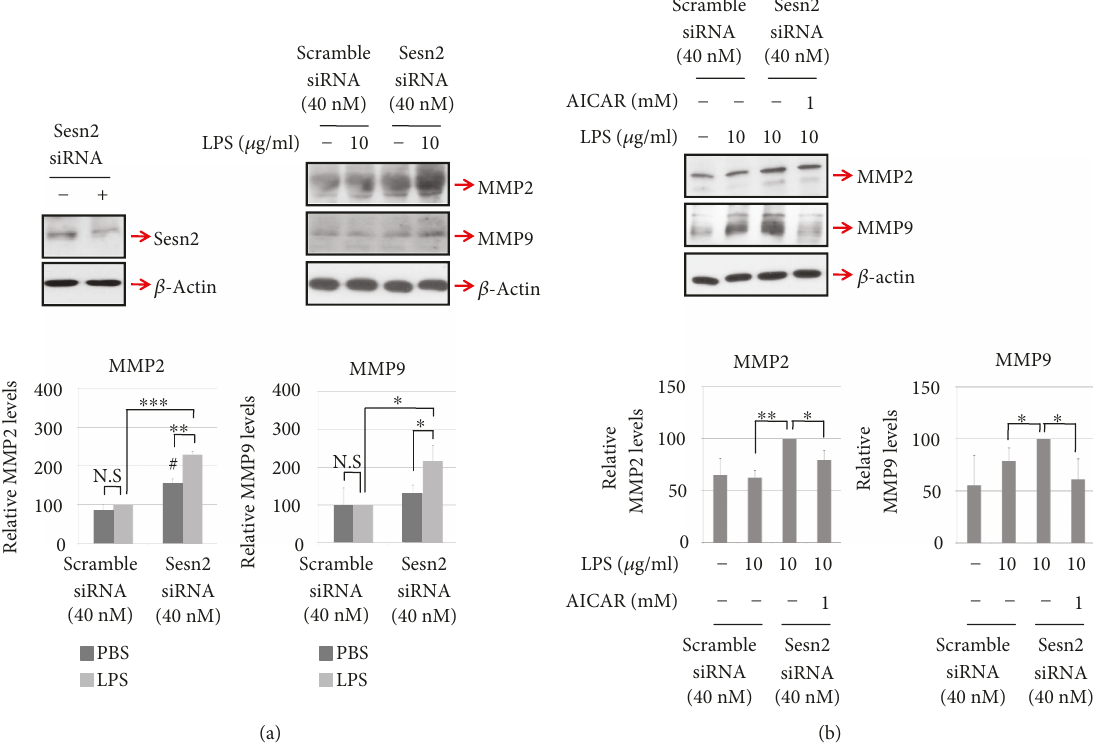
Figure 3: LPS-induced expression of MMP2 and MMP9 is increased by sesn2 knockdown in H9c2 cells. (a and b) Sesn2 knockdown cells were stimulated with LPS or LPS plus AICAR for 6 h, after which Western blotting was performed to assess the levels of MMP2 and MMP9. All graphs were obtained from three independent experiments. Data are presented as means; error bars represent ± SD (NS: not signi fi cant; # P < 0 05 versus control; ∗ P < 0 05 ; ∗∗ P < 0 005 ; ∗∗∗ P < 0 0005 ;